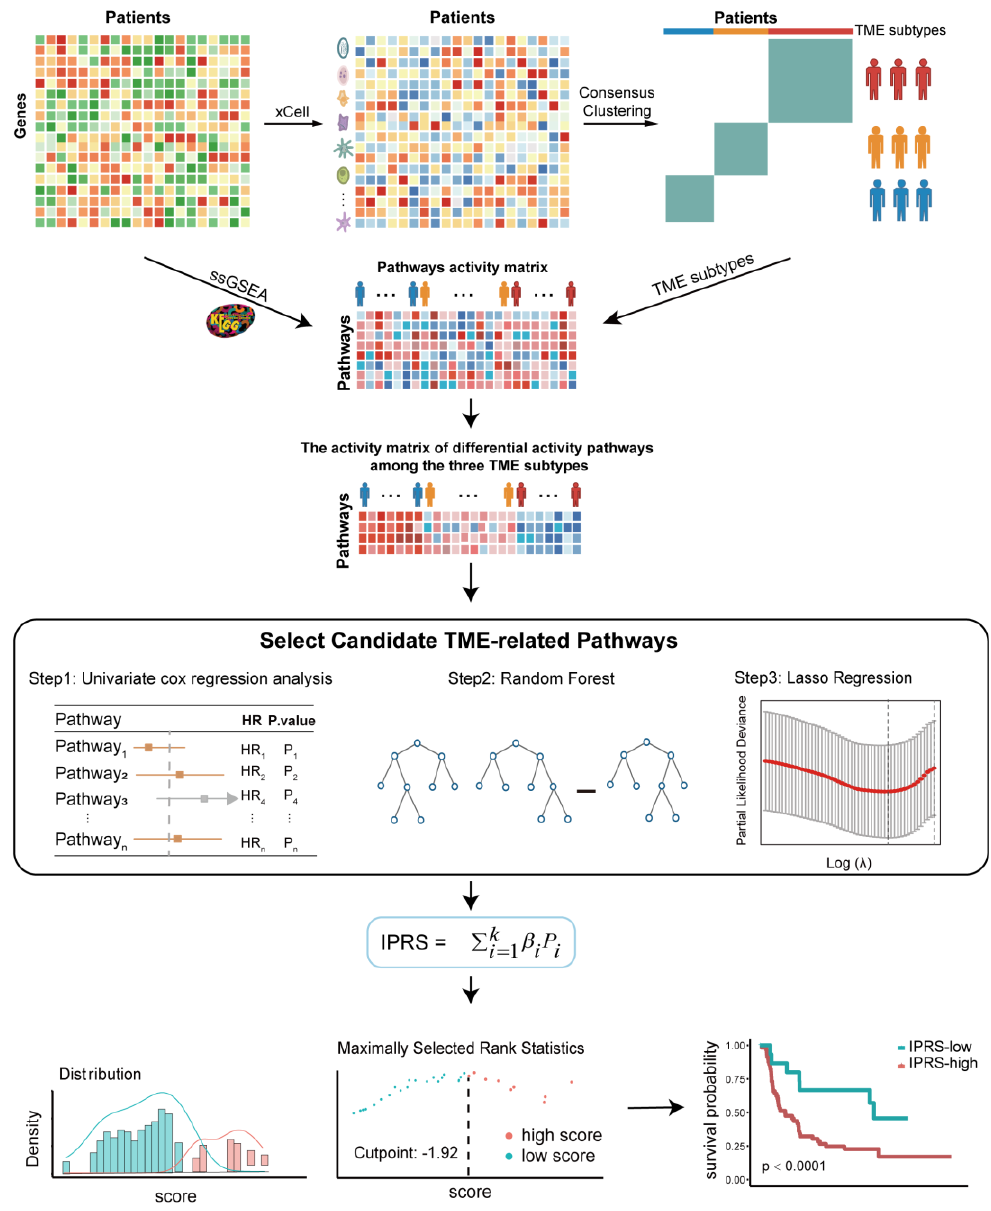
Figure 1. Flowchart for constructing IPRS based on pathway activity in breast cancer patients.